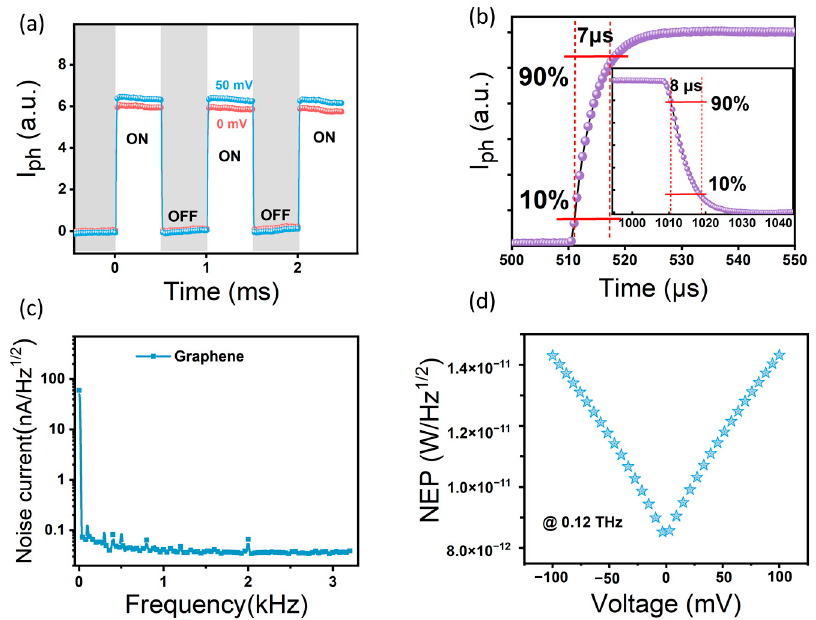
Figure 4. ( a ) Photoresponse waveform under different biasing conditions. ( b ) Response time of THz detector. ( c ) Voltage noise spectra of the device without biasing voltage. ( d ) Equivalent noise power of the device.